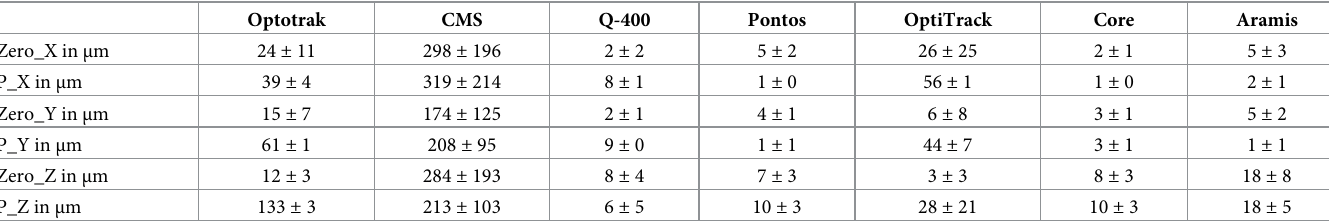
Table 4. Mean measurement errors and standard deviation of the zero offset condition of the seven